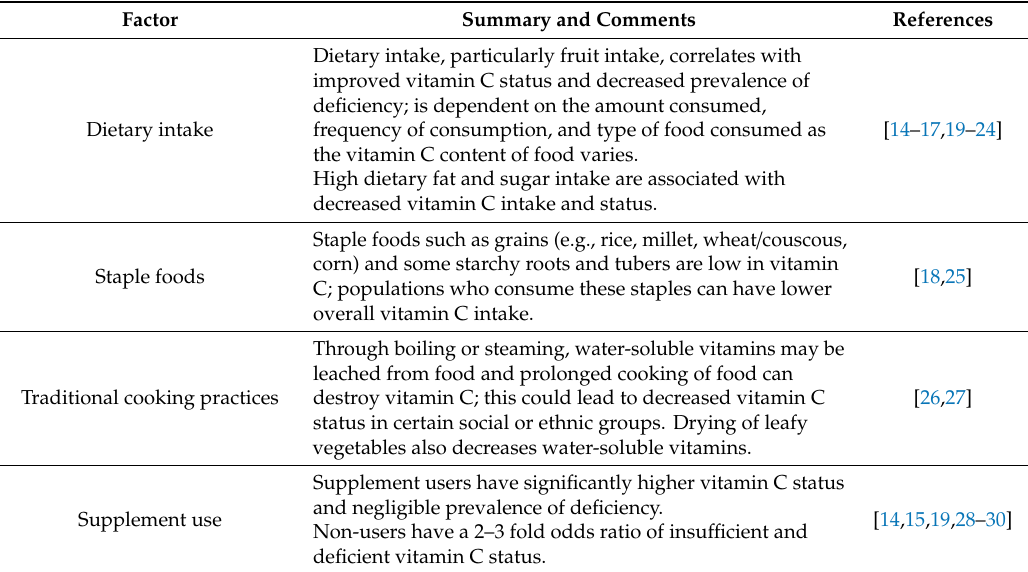
Table 1. Dietary factors determining vitamin C